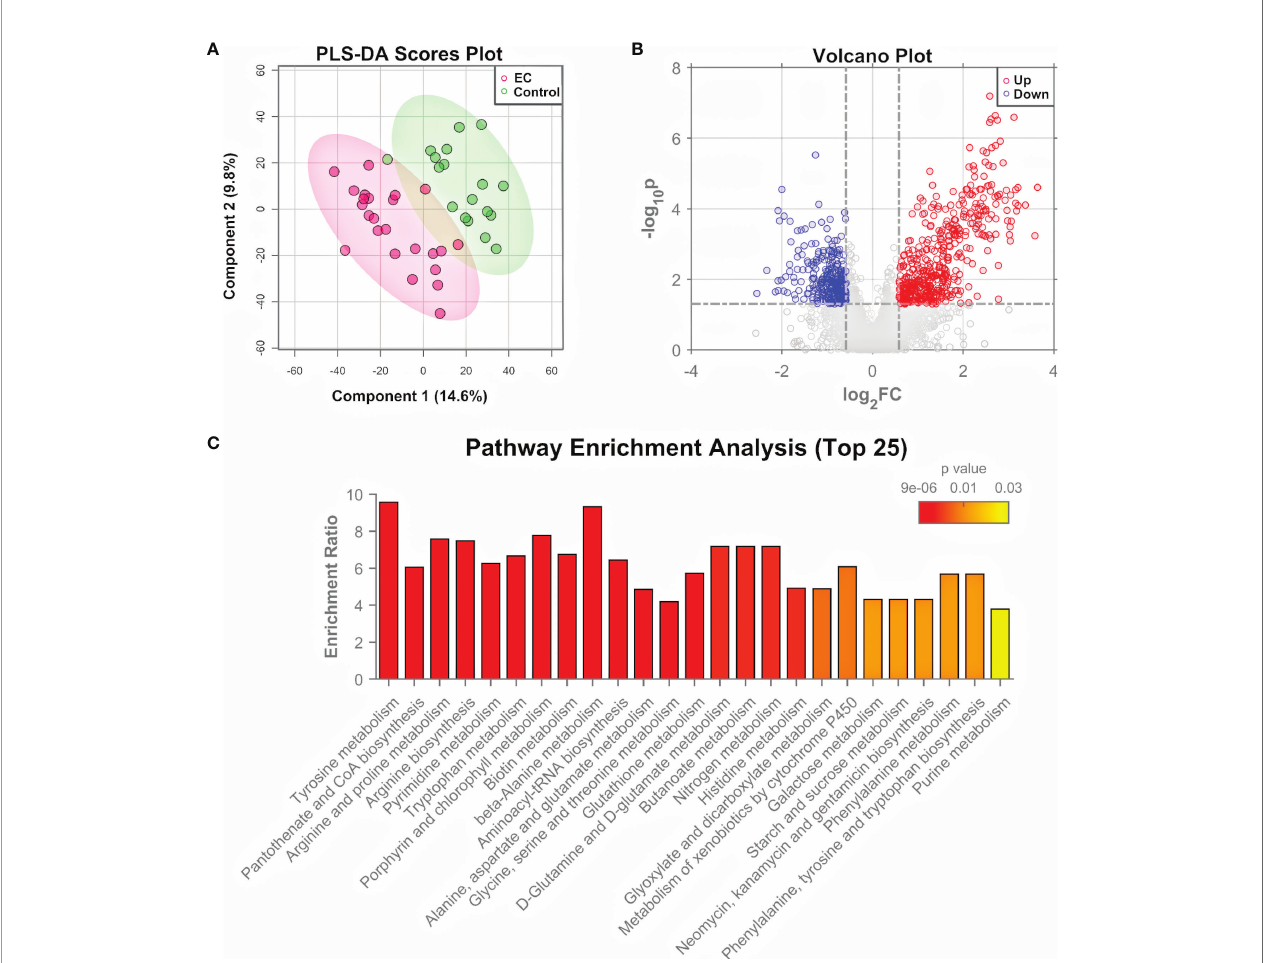
FIGURE 2 | Metabolomic analysis of EC tissue samples. (A) PLS-DA score plot for metabolomic data of tissue samples collected from EC and control groups by LC-MS/MS in the positive ion mode. (B) Volcano plots of features from the metabolomic data with log 2 (FC) as the horizontal axis and − log 10 ( p -value) as the vertical axis. FC, fold change of EC to control. (C) Pathway enrichment analysis of differential metabolites identi fi ed from the tissue samples of EC and control groups, showing the results of the top 25 enriched metabolomic